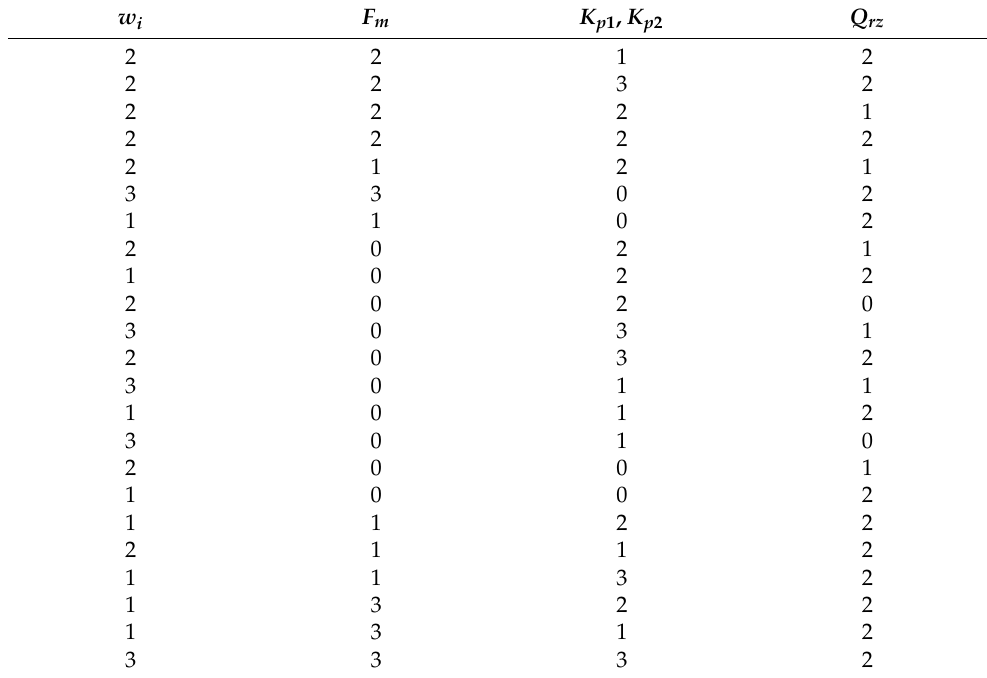
Table 1. KAPN for the K p 1 , K p 2 , Q rz and F m parameter code data, taking into account the w i weighting factors. w i F m